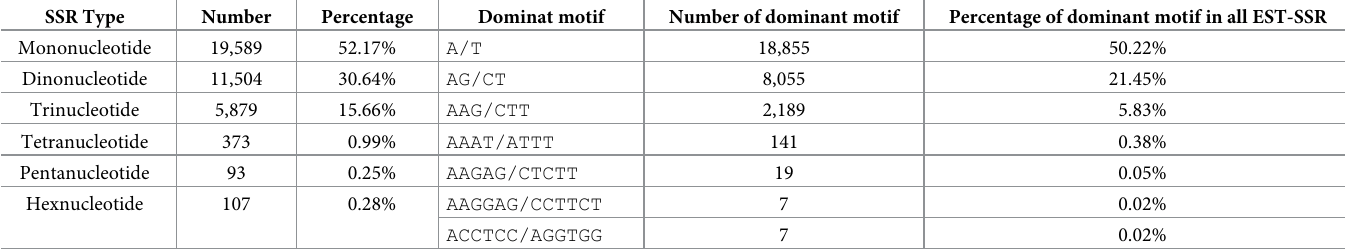
Table 2. Summary of EST-SSRs identified from the transcriptome of Rosa roxburghii